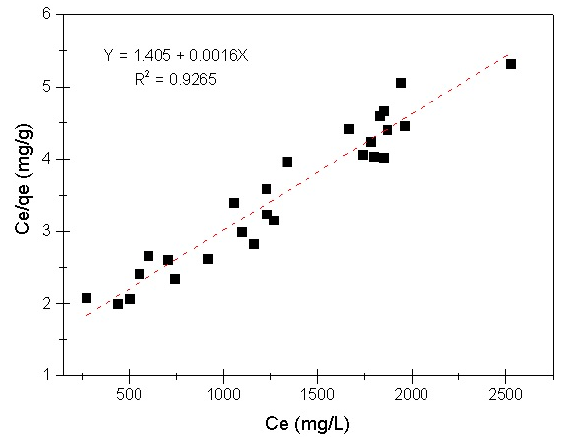
Figure 4. Adjusted linearized Langmuir isotherm model ( -- ) vs. the experimental results ( ■ ).